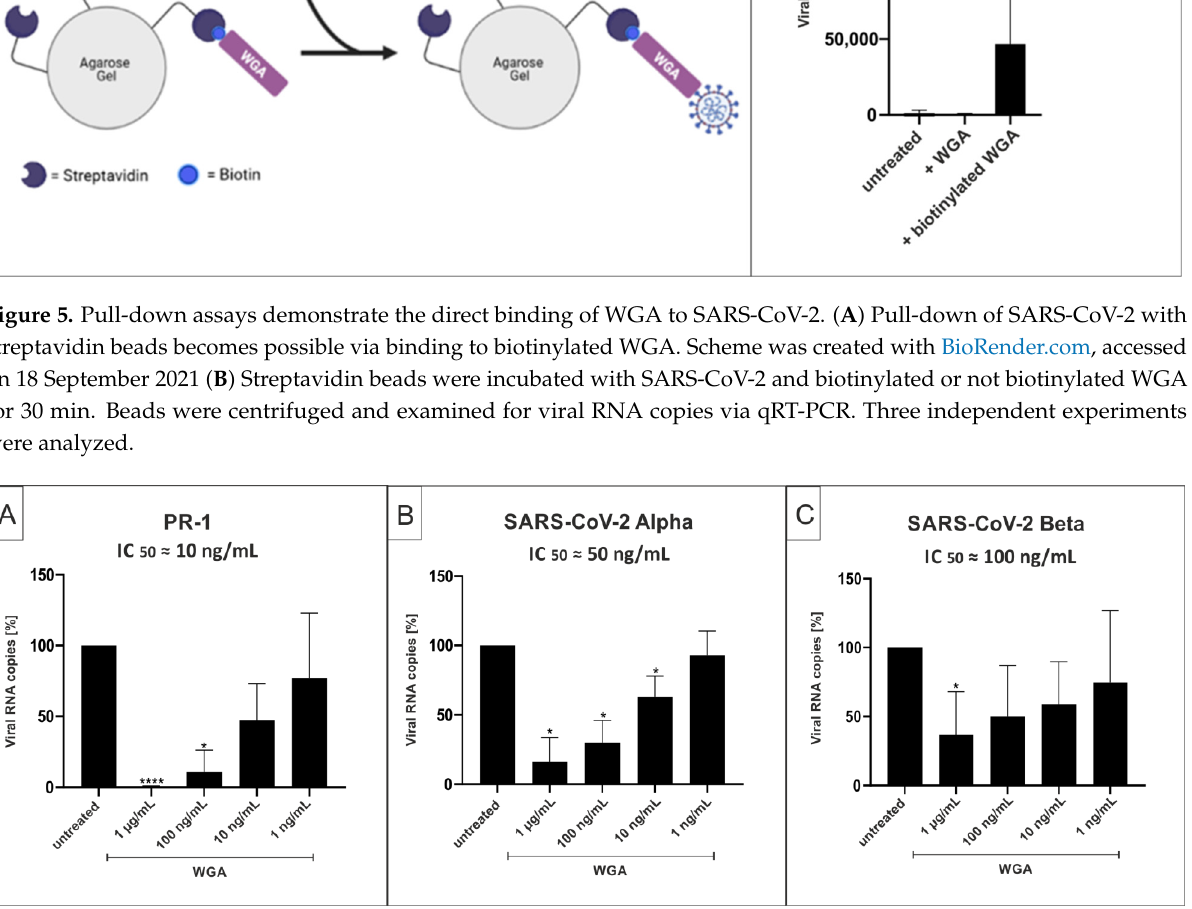
Figure 6. WGA inhibits replication of SARS-CoV-2 PR-1 , Alpha and Beta in Calu-3 cells. qRT-PCR analysis of cell culture supernatants after 3 days of treatment with WGA. Calu-3 cells were infected with either SARS-CoV-2 PR-1 ( A ), Alpha ( B ) or Beta ( C ) and supernatants were harvested 3 dpi. Bars show analysis of three ( A , B ) or four ( C ) independent experiments. * p ≤ 0.05 and **** p < 0.0001 using a one-sample t-test.